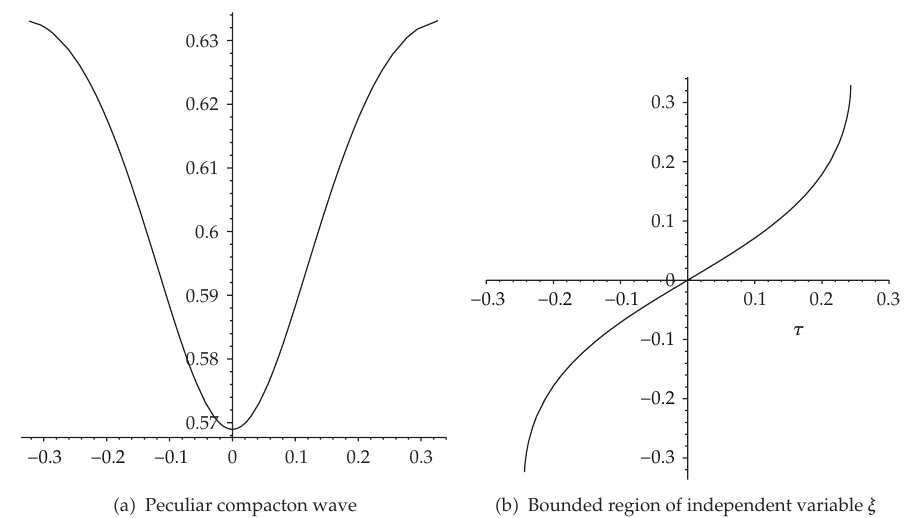
Figure 6: Peculiar compacton wave and its bounded region of independent variable ξ